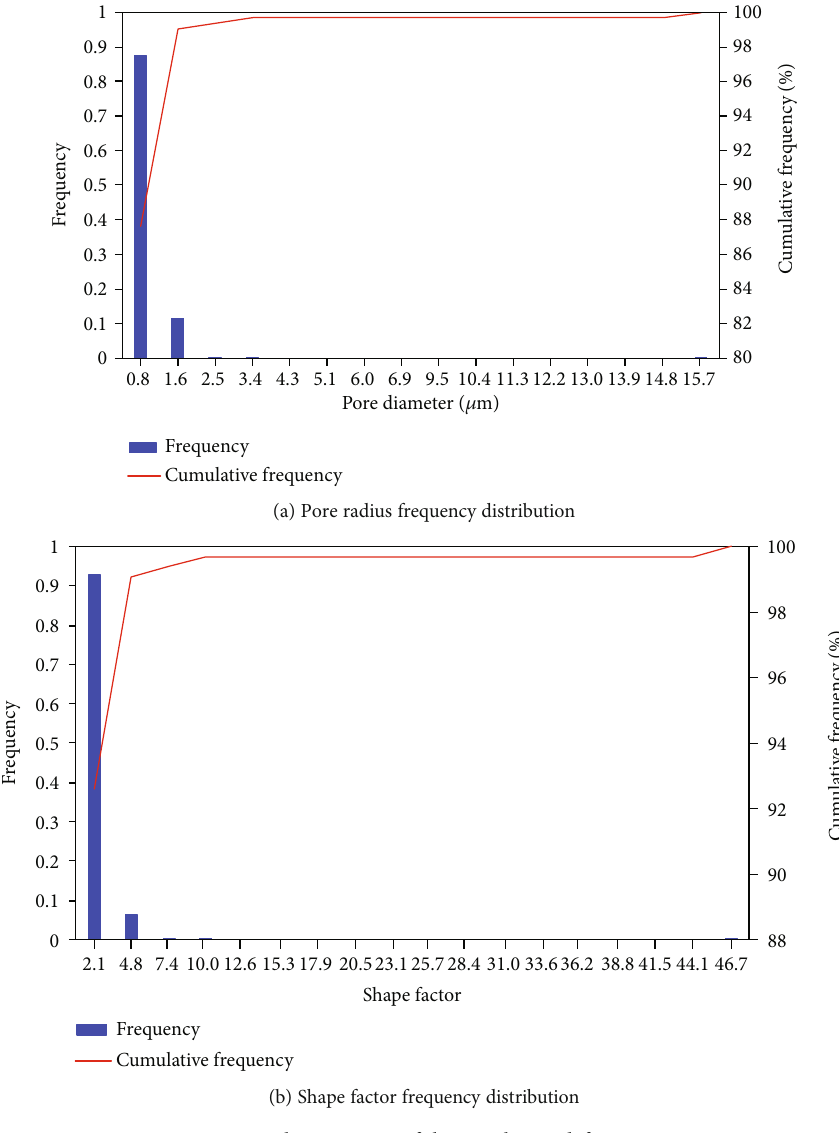
Figure 9: Statistical parameters of the simulation deformation